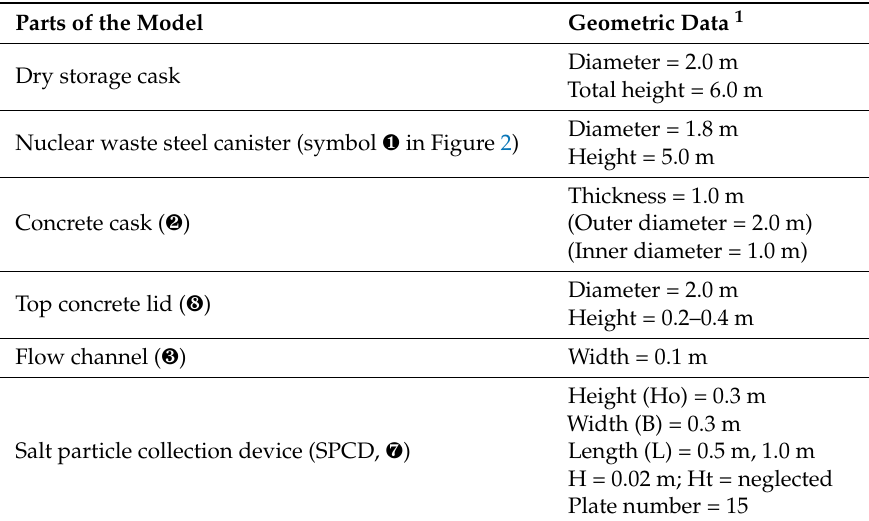
Table 1. The geometric data used in the investigated model.